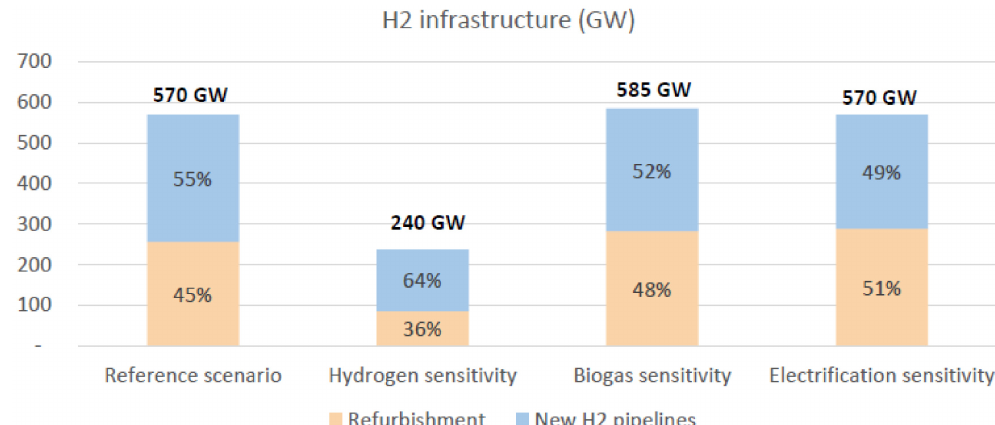
Figure 8. Distribution of investment in H2 (hydrogen) pipelines (distinguished between repurposing and new H2 pipelines for the reference scenario and the 3 sensitivity